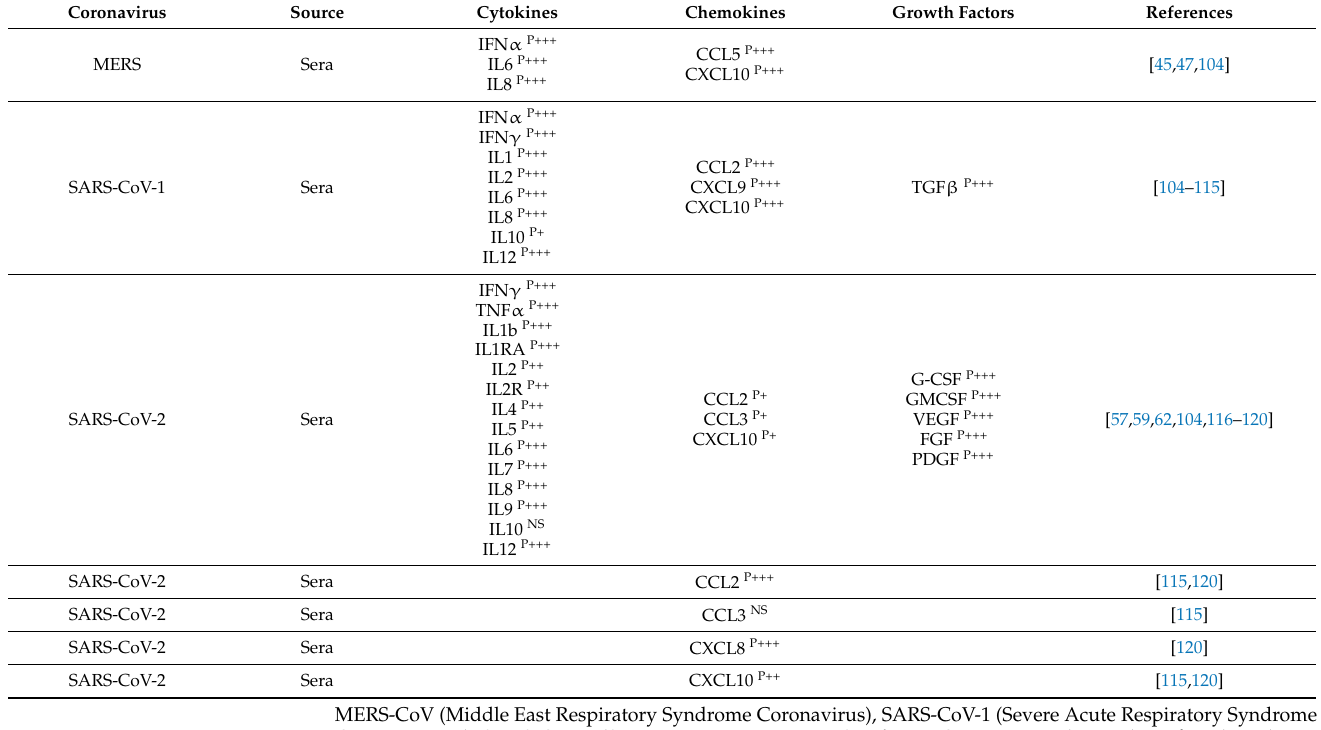
Table 2. Coronavirus-induced production of circulatory cytokines.